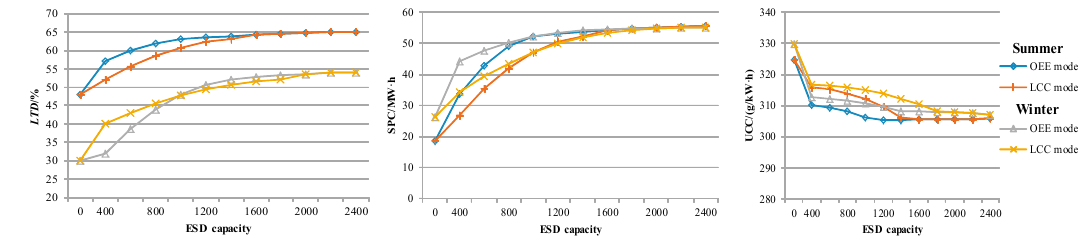
Figure 16. The complementarity indexes of MECS operation under different ESD capacities.